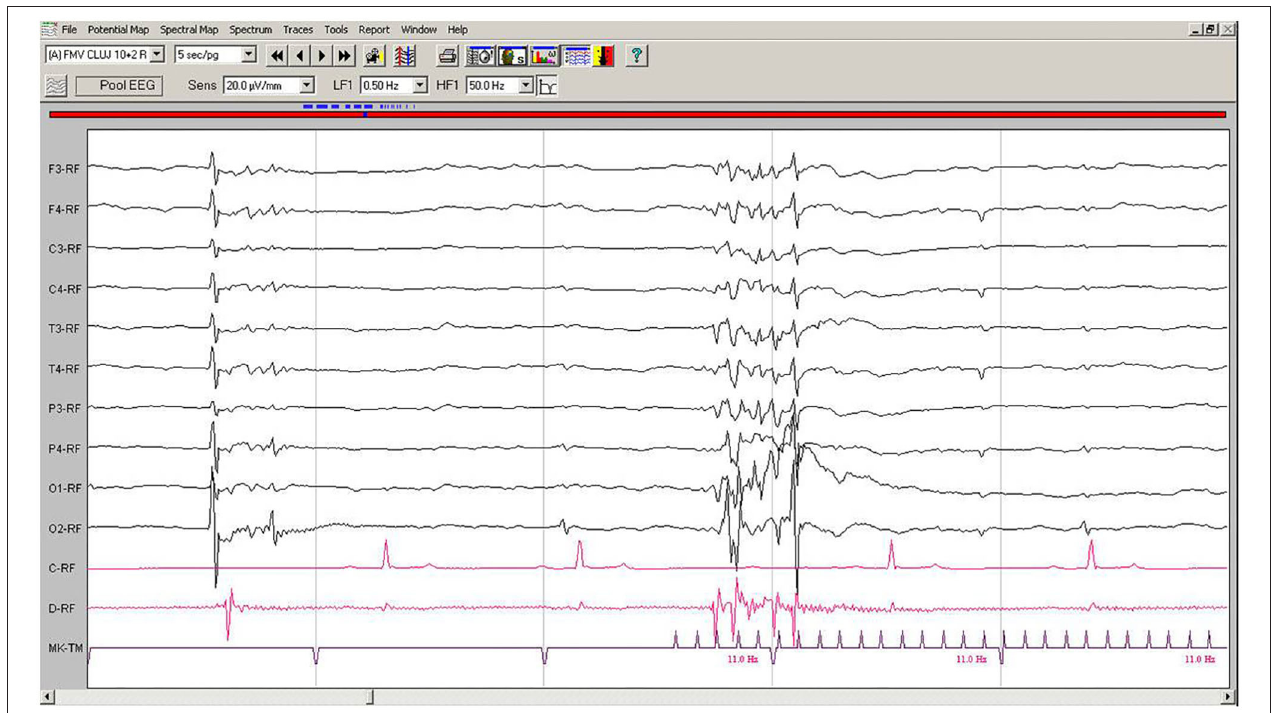
FIGURE 4 | IPS-induced EEG recording of Case No. 2 patient: IPS at 11Hz generates after 120ms generalized polyspike-slow wave complexes, followed immediately by the myoclonic contraction on the EMG channel. Low-cut filter: 0.5Hz; high-cut filter: 50Hz, speed 5 sec/page; channel C: ECG, bipolar on the chest, channel B: bipolar, left brachiocephalic muscle; channel D: bipolar, right brachioradialis muscle; MKT channel: photic stimulation marker. Figure shown at 20 µ V/mm. IPS, intermittent photic stimulation; EEG, electroencephalogram; ECG, electrocardiography; EMG, electromyography.